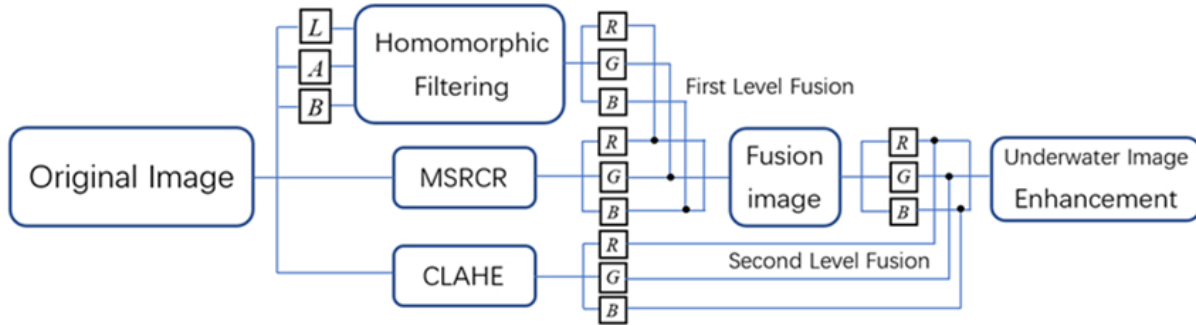
Figure 2. Structure of underwater image enhancement fusion